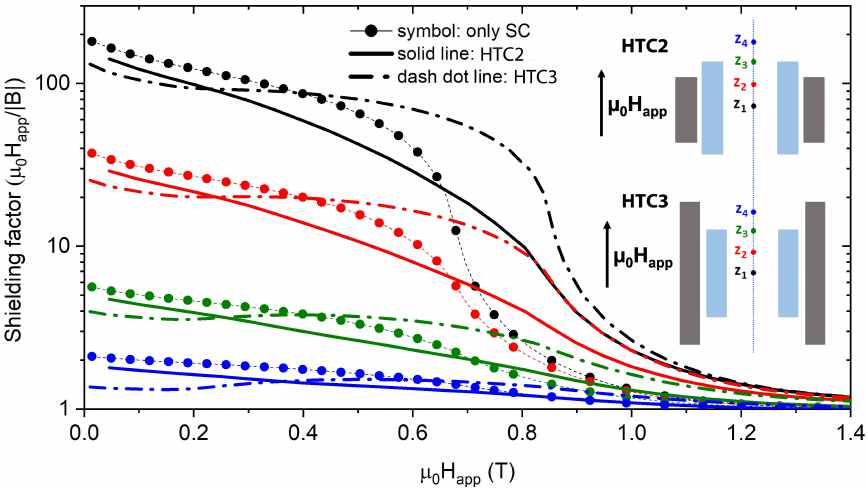
Figure 6. Comparison between the SFs of the single SC tube and of the configurations HTC2 and HTC3 in the AF mode. Assuming (x,y,z) = (0,0,0) the coordinate of the tube center, the plotted curves were calculated at the z values: z 1 = 0 mm, z 2 = 4.4 mm, z 3 = 8.8 mm (SC shield edge coordinate), and z 4 = 13.1